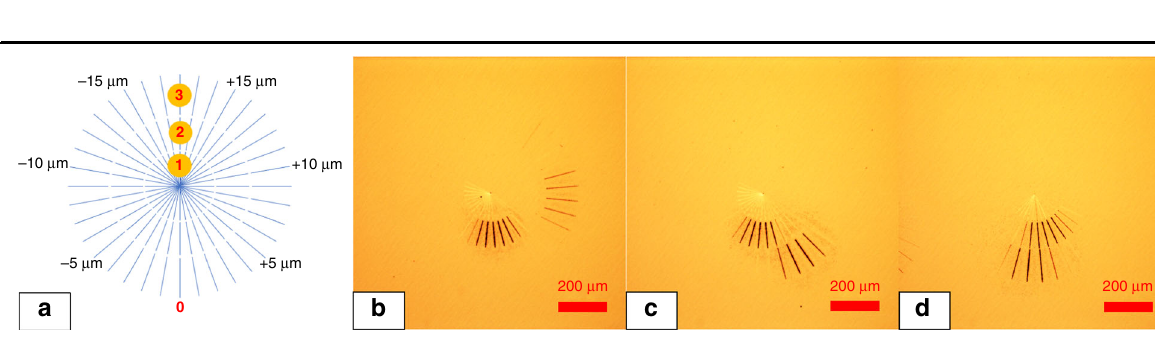
optimised. When the laser beam is re fl ected or trans- mitted through so many optical elements in the beam path, the beam mode has gradually deteriorated. Figure 12 shows the comparison of the collimated original